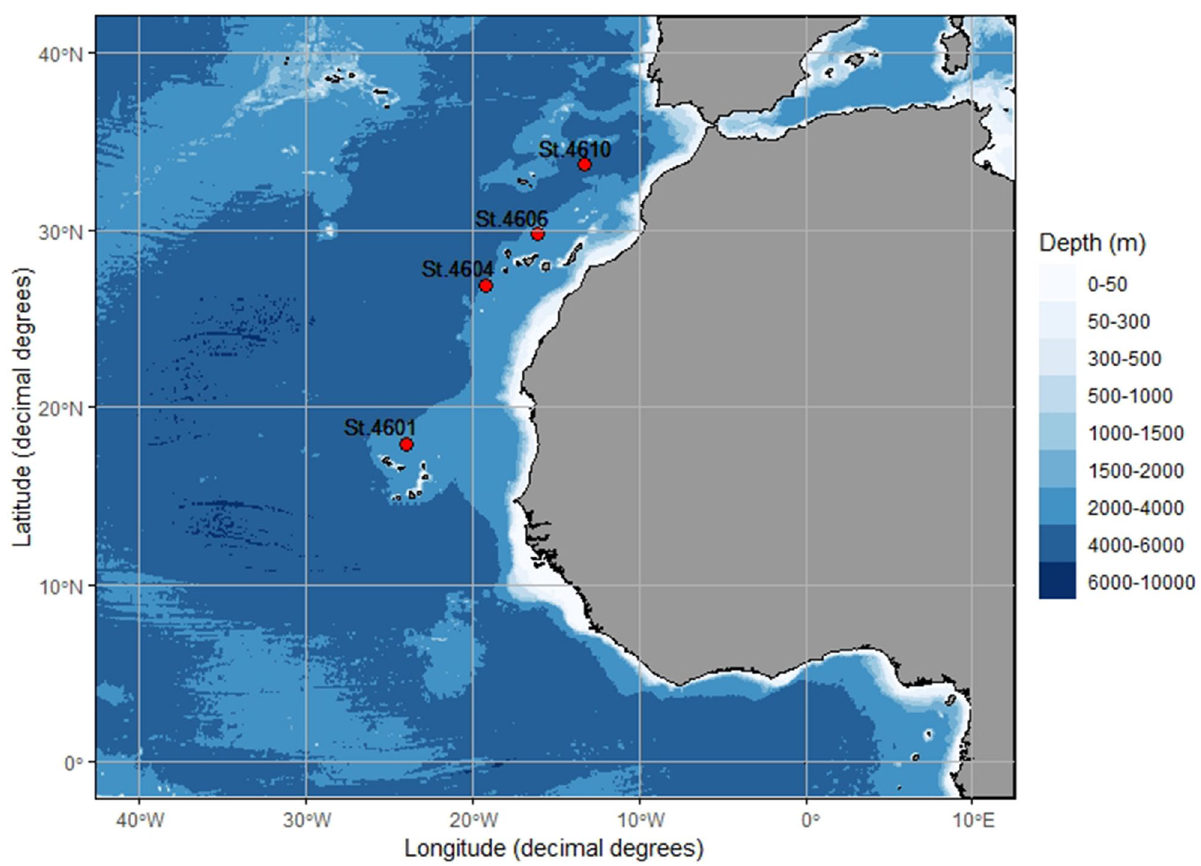
Figure 1. Trawl stations from which infected fish hosts were obtained. Positions: station (st.) 4601: 17.969 N, 23.956 W; st. 4604: 26.899 N, 19.232 W; st. 4606: 29.767 N, 16.087 W; st. 4610: 33.695 N, 13.232 W. Figure 1 was created using R version 4.95 (2021–03-31) (https:// www.r- proje ct. org/) implemented in RStudio 1.4.1106 (https:// www. rstud io. com/) using.